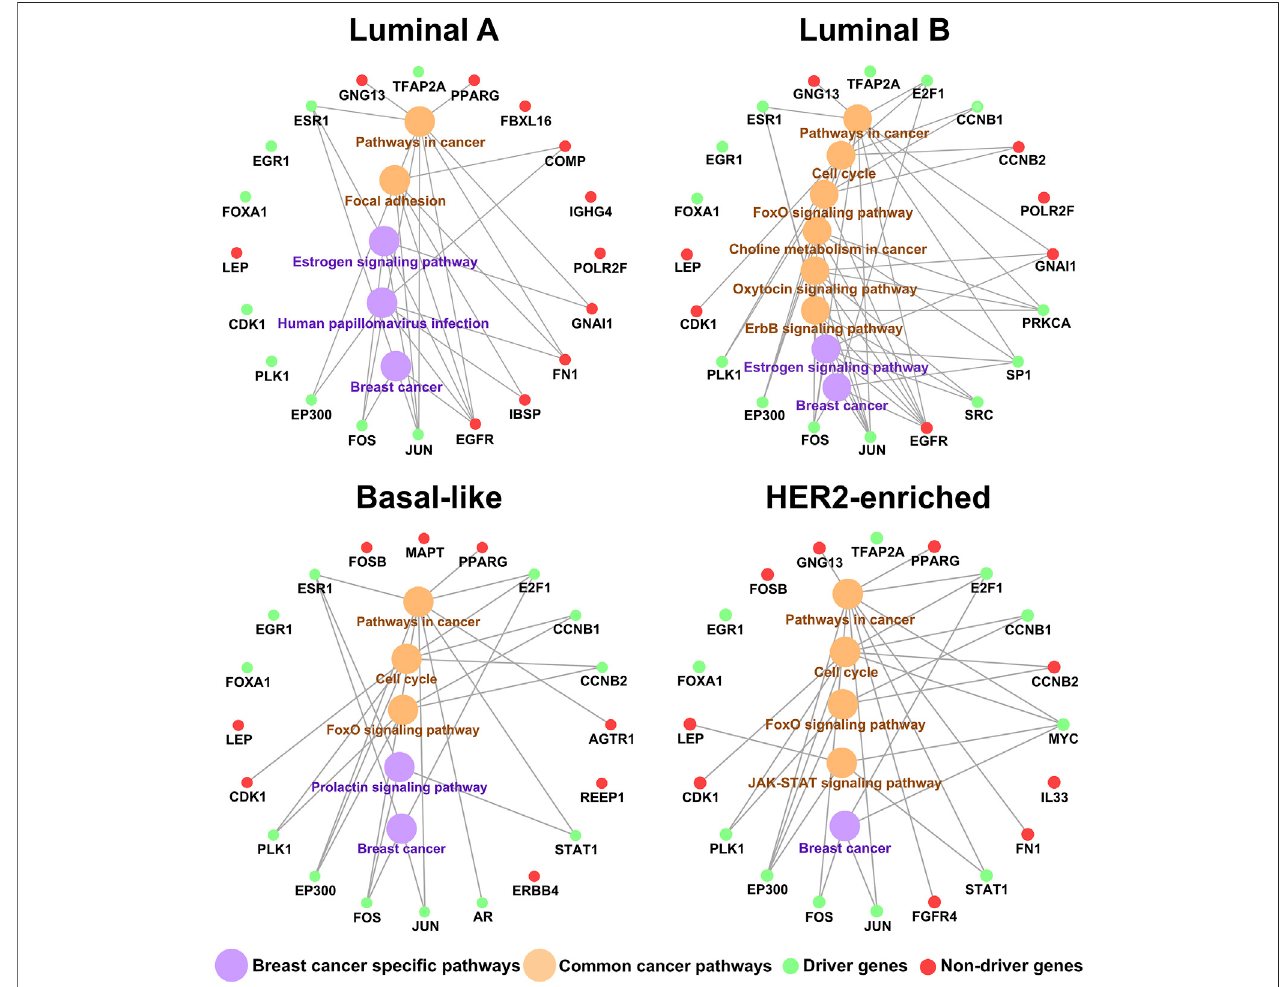
FIGURE 3 | The relation of the top 20 key genes and their enriched